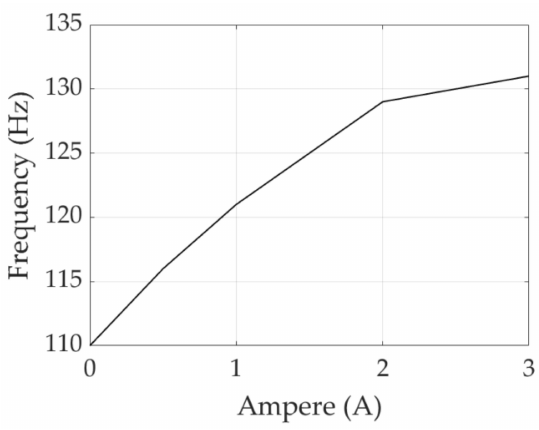
Figure 21. Reduction frequency of ATMVA due to induced